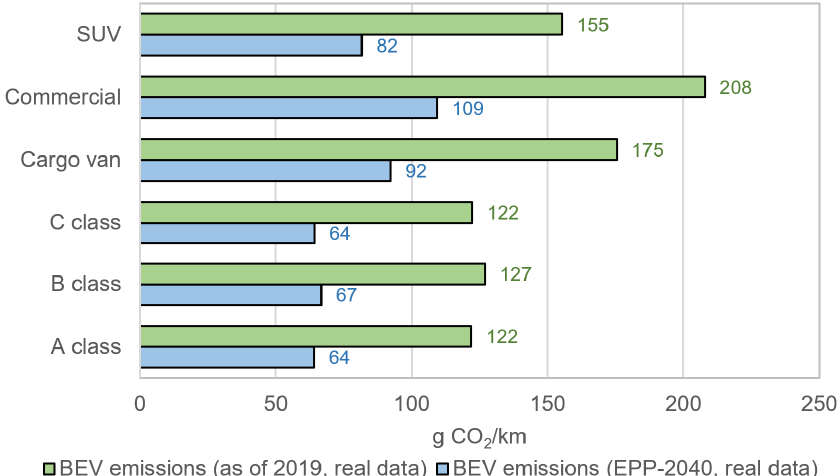
Figure 6. Emission levels for BEVs for each category—comparison based on the carbon intensity of the Polish power sector: fuel mix in 2019 vs. fuel mix in 2040 (EPP2040).